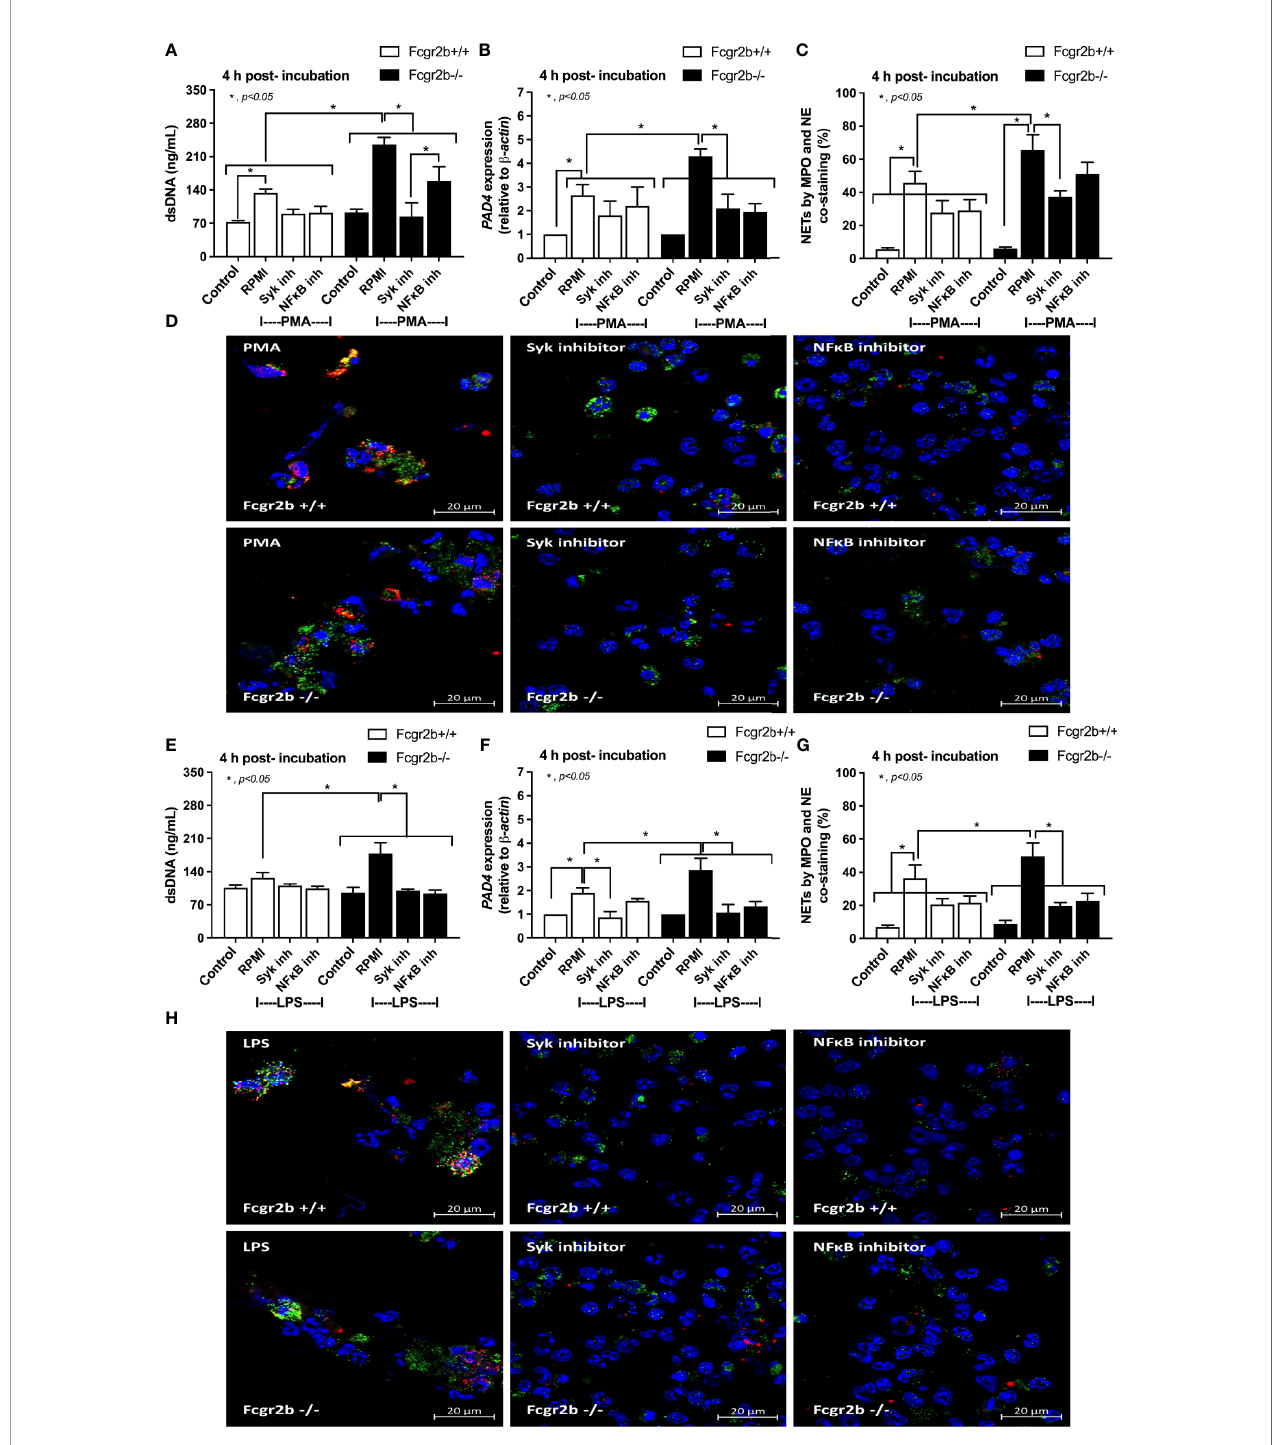
FIGURE 9 | The inhibitors against Spleen tyrosine kinase (Syk) or Nuclear factor kappa B (NF k B) attenuated neutrophil extracellular traps (NETs). NETs formation in Fcgr2b-/- and wild-type (Fcgr2b+/+) neutrophils after 4 h activation by phorbol myristate acetate (PMA), a NETs activator, with or without inhibitors against Syk (Syk inhibitor) or NF k B (NF k B inhibitor) as determined by supernatant dsDNA (A) , PAD4 expression (B) and co-staining of myeloperoxidase (MPO) and neutrophil elastase (NE) with the representative immuno fl uorescent pictures (C, D) are demonstrated. In parallel, NETs formation after activation by lipopolysaccharide (LPS), a TLR-4 stimulator, with or without the inhibitors as determined by the same parameters (E – H) are also demonstrated (independent triplicated experiments were performed). RPMI, Roswell Park Memorial Institute media (for neutrophils); Control group using only RPMI without the